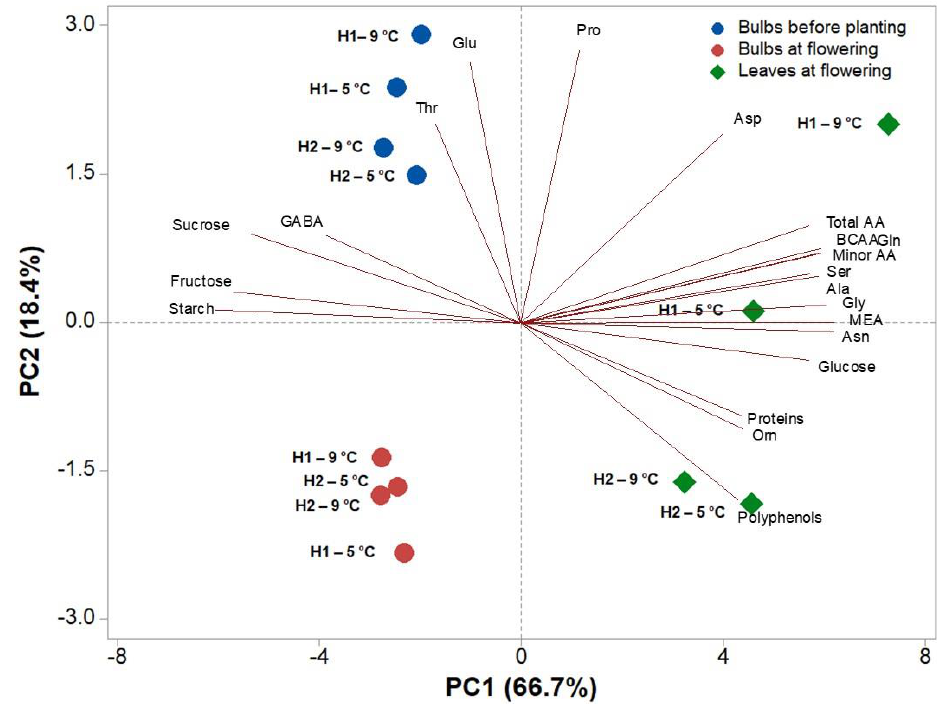
Figure 2. Principal component loading plot and scores of principal component analysis (PCA) of metabolic profile parameters of bulbs and leaves of tulip hybrids ‘Royal Virgin’ and ‘Ad Rem’, grown hydroponically from bulbs subjected to two preparation procedures, 9 + 5 °C and 5 + 5 °C.